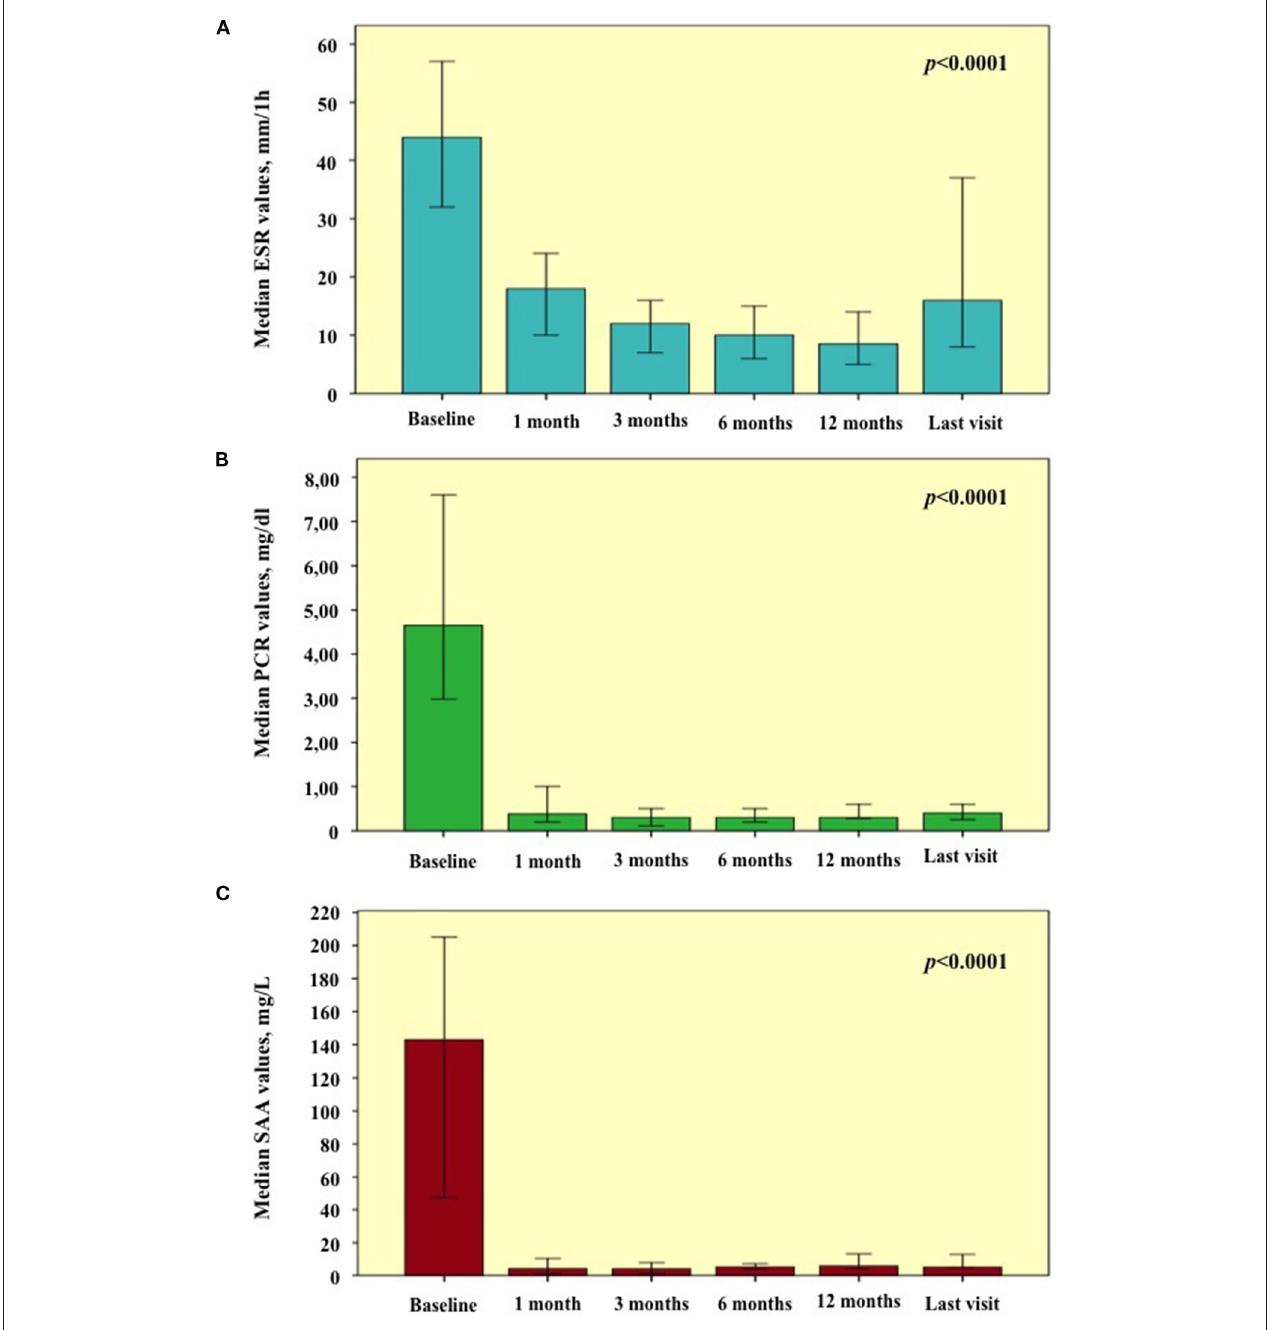
FIGURE 4 | Laboratory inflammatory markers observed at the start of treatment courses (baseline) and during the following visits. Graphics are referred to (A) erythrocyte sedimentation rate (ESR); (B) C-reactive protein (CRP); (C) serum amyloid A (SAA). Error bars refer to one standard error.